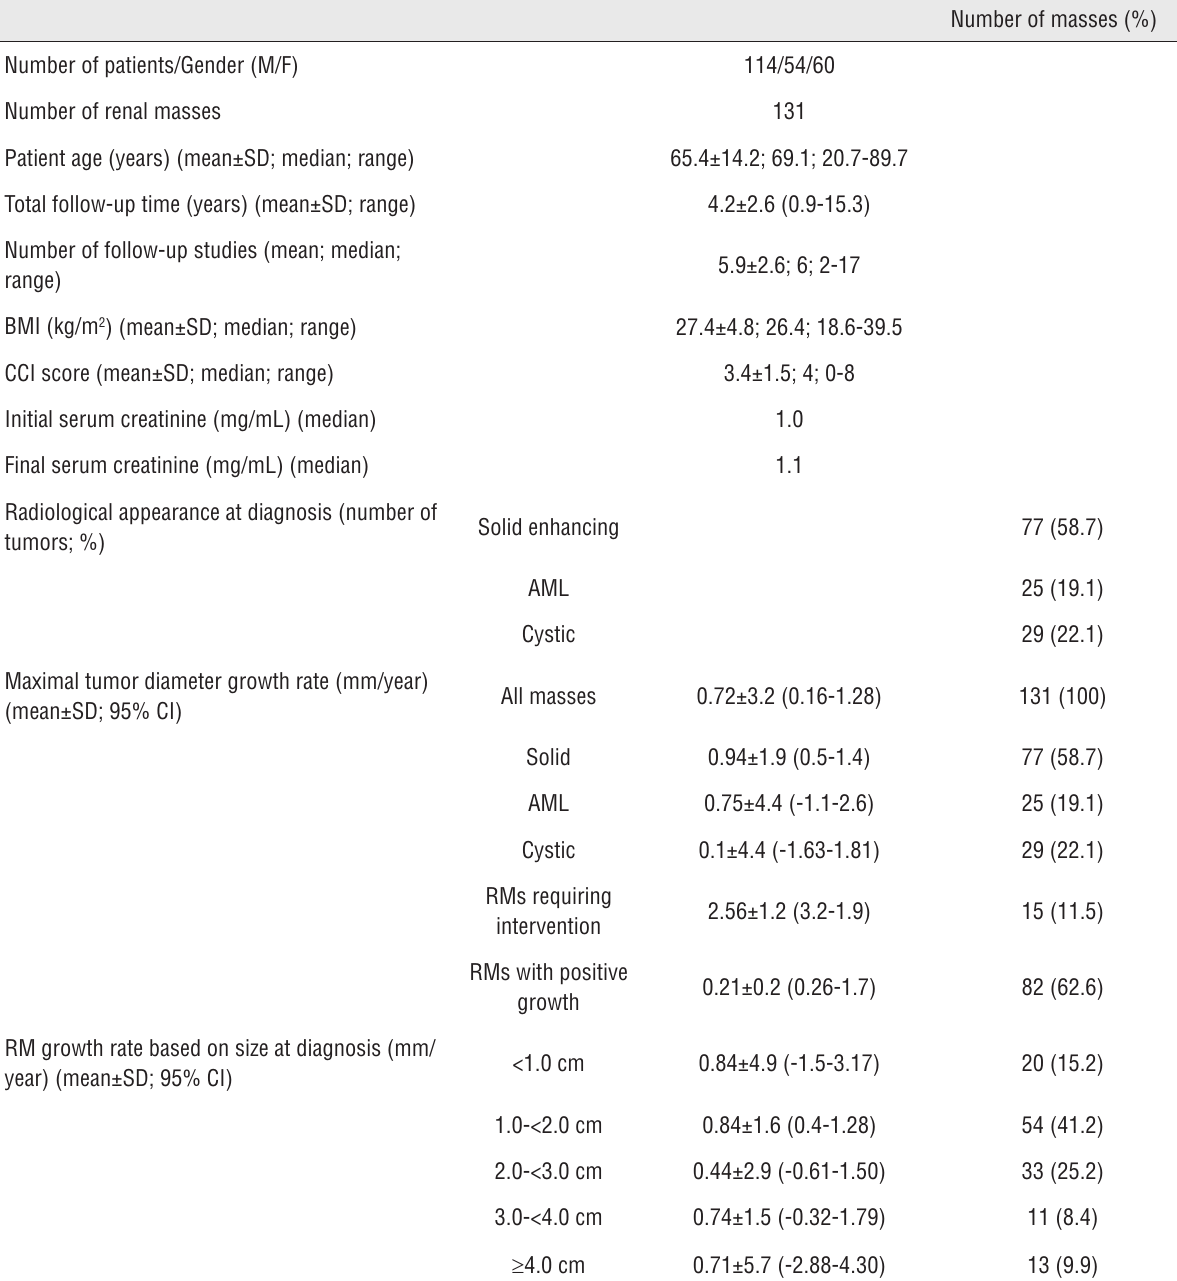
Number of masses (%)